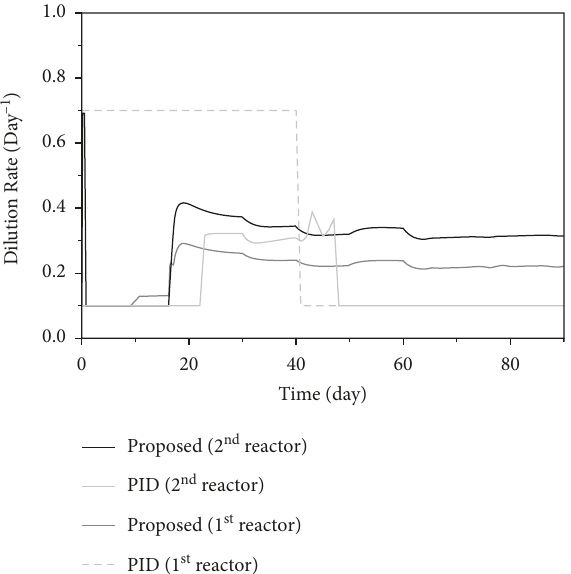
Figure 9: Dilution rate profiles corresponding to Figure 8.